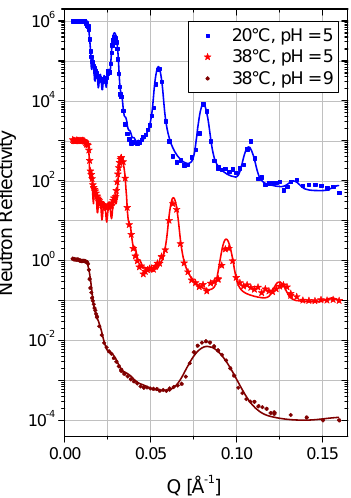
Figure 1. Neutron reflectivity curves of sample A, incubated in a solution of PAH-58 in D 2 O at pH = 5 at 20 °C, 38 °C and again at 20 °C from top to bottom. For clarity, the curves are shifted vertically. Solid lines are best fits to the data according to the model gathered in Table 1.